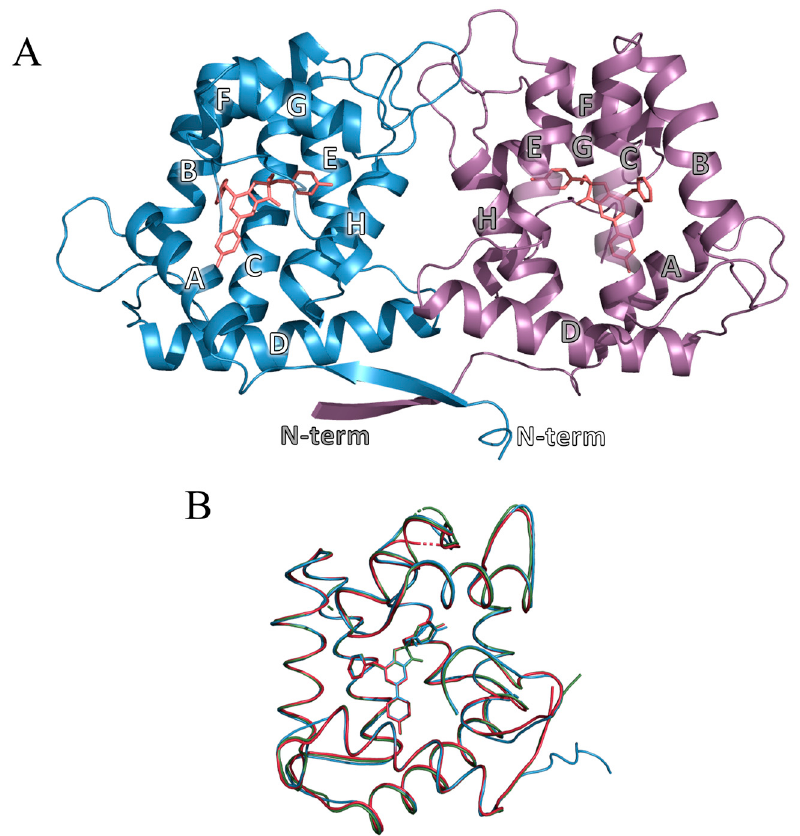
Figure 4. Crystal structure of OL_H64F mutant. ( A ) Overall structure of OL_H64F mutant. The helices are marked by letters A–H. ( B ) Superimposition of OL_H64F mutant (blue, PDB 8C6O, chain A), wild-type obelin (red, PDB 1QV0), and OL_Y138F mutant (green, PDB 4MRX).